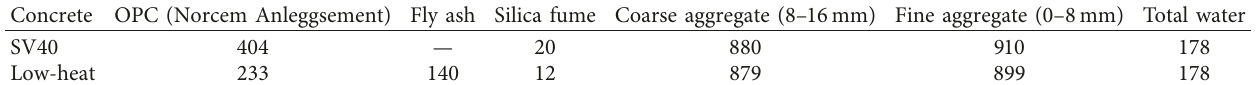
Table 1: Concrete composition, all values in kg/m 3 .